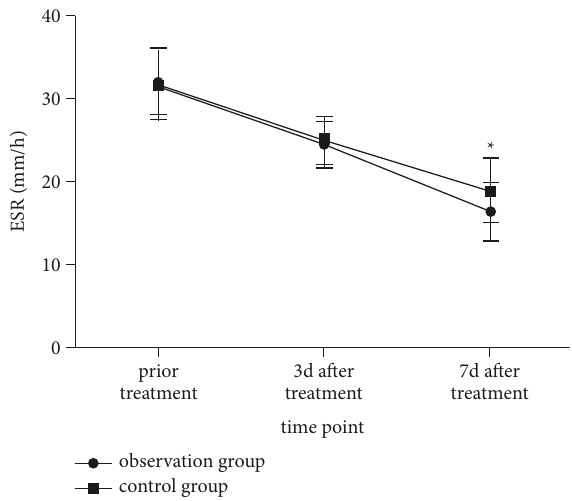
Figure 13: Comparison of ESR between the two groups before and after treatment.